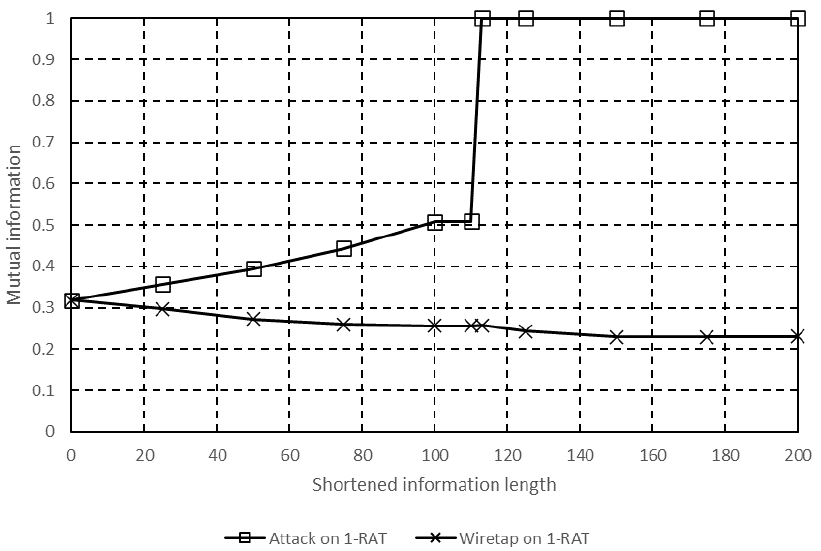
Figure 10. Characteristics of the mutual information versus the shortened information length when the sender and the receiver communicate using two RATs. The square marks indicate the mutual information between the sender and the receiver when one RAT cannot be used for communication due to an attack, and the cross marks indicate the mutual information between the sender and the cyberterrorist when one RAT is wiretapped.